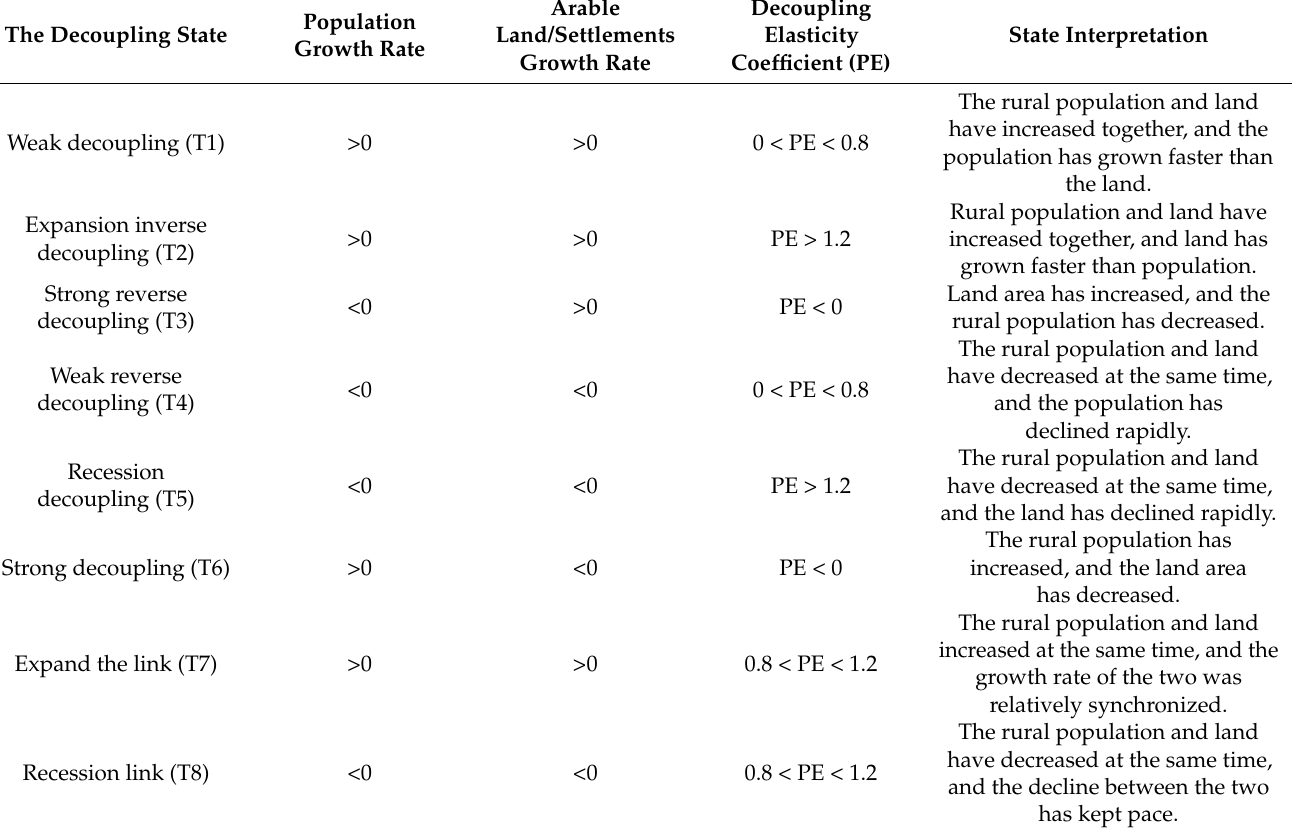
Table 1. The rural population, arable land, and rural settlements decoupling state